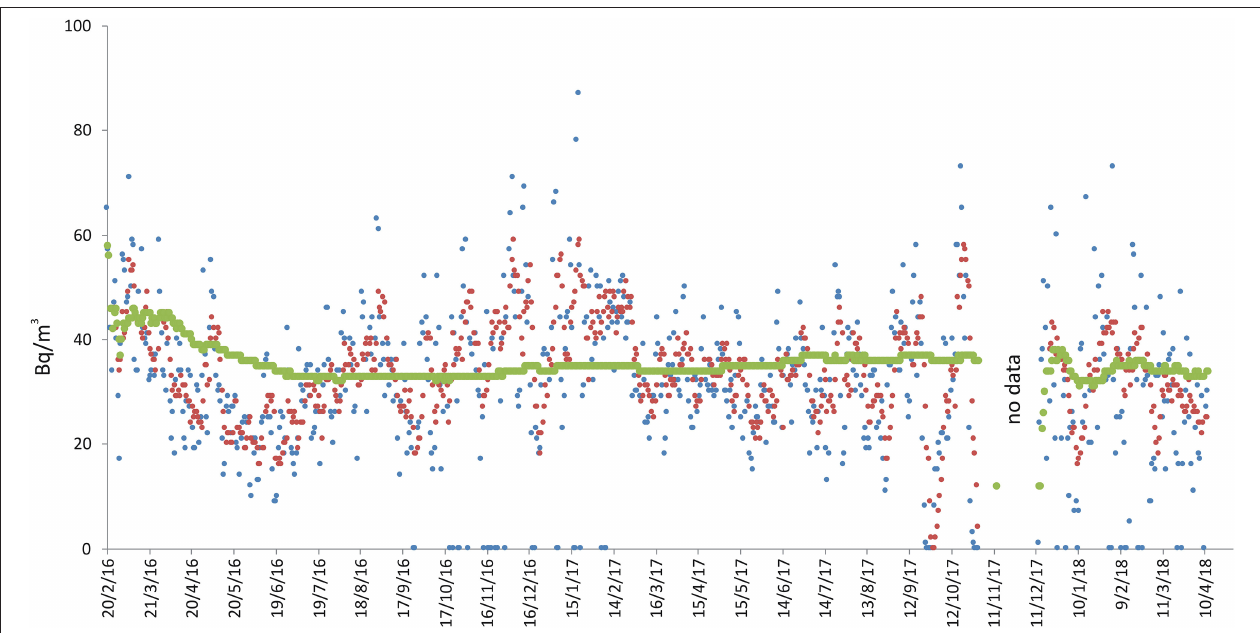
FIGURE 2 | Radon measurements recorded at site 1 in Paternò (see Figure 1 for location). Radon concentration are presented as daily (blue line), weekly (red) and long-term (green) averages. “No data” indicates periods of no acquisition due to battery